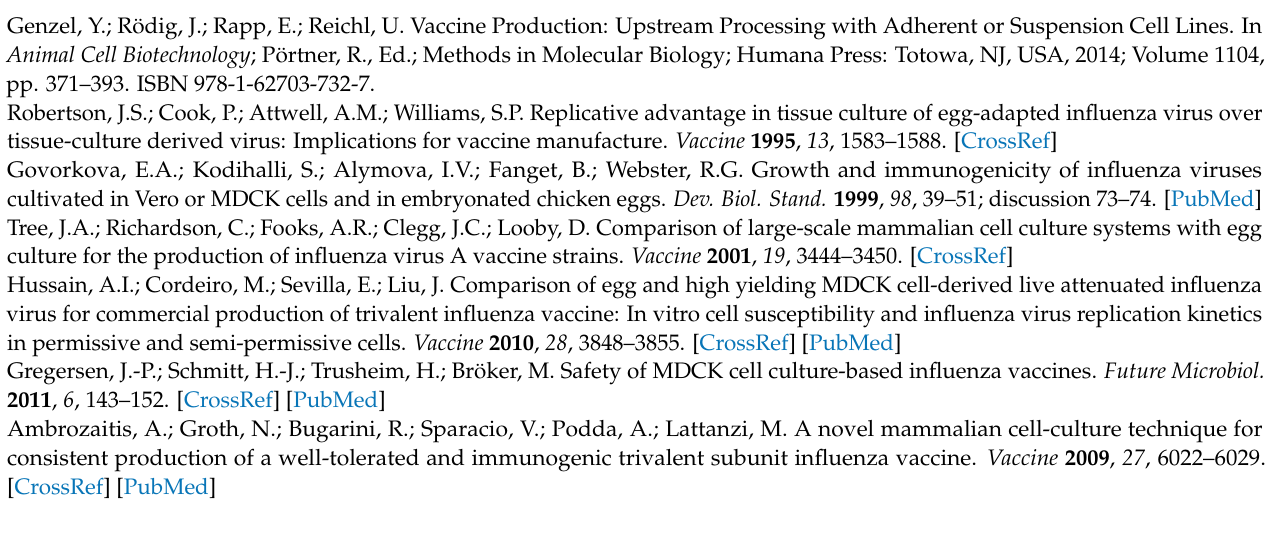
Figure S2: Results of 2500 simulations using the parameters obtained via a bootstrap method for the model established for mock-infected and infected suspension MDCK cells; Figure S3: Simulated rates and standard deviations for Cultivation 1 and 2 (mock-infected –, infected), calculated from 2500 simulations via a bootstrap method; Figure S4: Box plot with average and standard deviation of intracellular rates estimated from model simulations for mock-infected and infected suspension MDCK cells; Figure S5: Simulated rates for Cultivation 1 and 2 (mock-infected –, infected); Table S1: Estimated global parameters of the structured intracellular model with confidence intervals between 0.025-quantile and 0.972-quantile (Q0.025–Q0.975), calculated via a bootstrap method with 2500 runs; Table S2: Estimated global parameters of the segregated cell growth model with confidence intervals between 0.025-quantile and 0.975-quantile (Q0.025–Q0.975), calculated via a bootstrap method with 2500 runs; Table S3: Initial conditions used for the simulation of the model estab- lished for mock-infected and infected suspension MDCK cells; Table S4: Experimental procedures; Supplementary File S1: Model definitions and equations; Supplementary File S2: List of